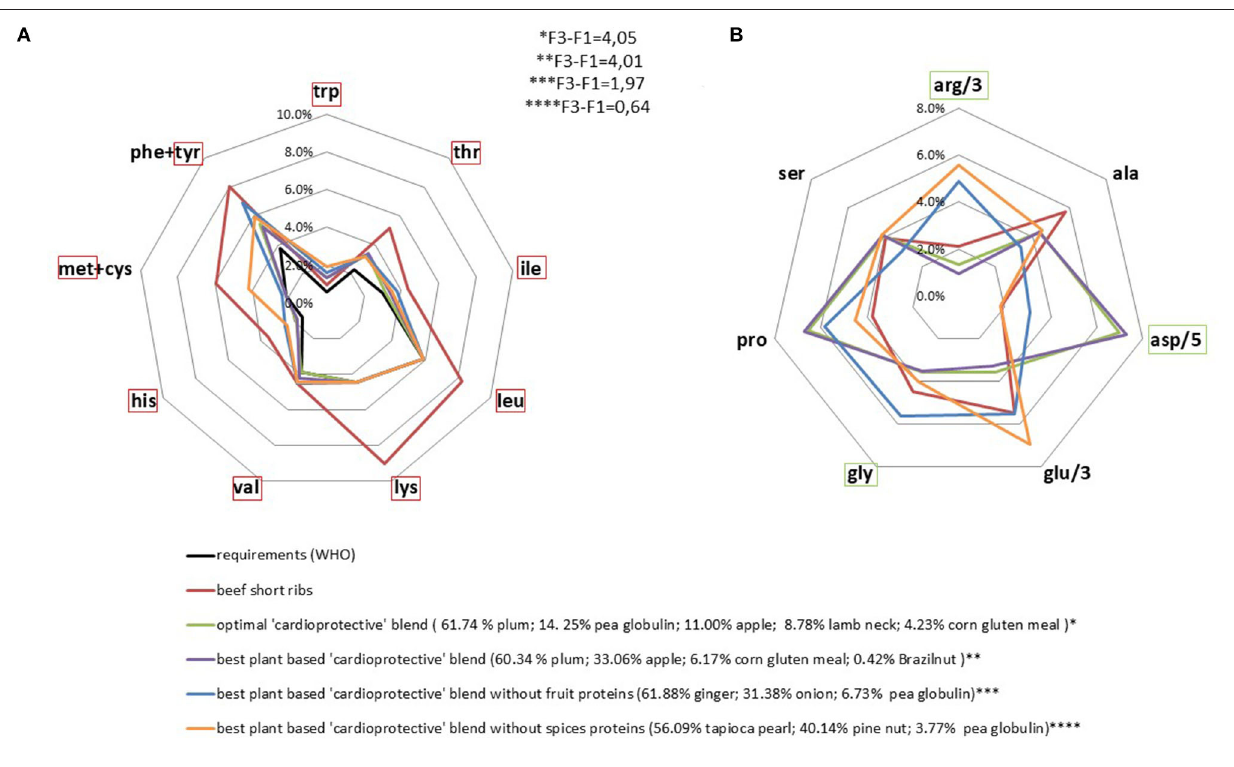
Frontiers in Nutrition |